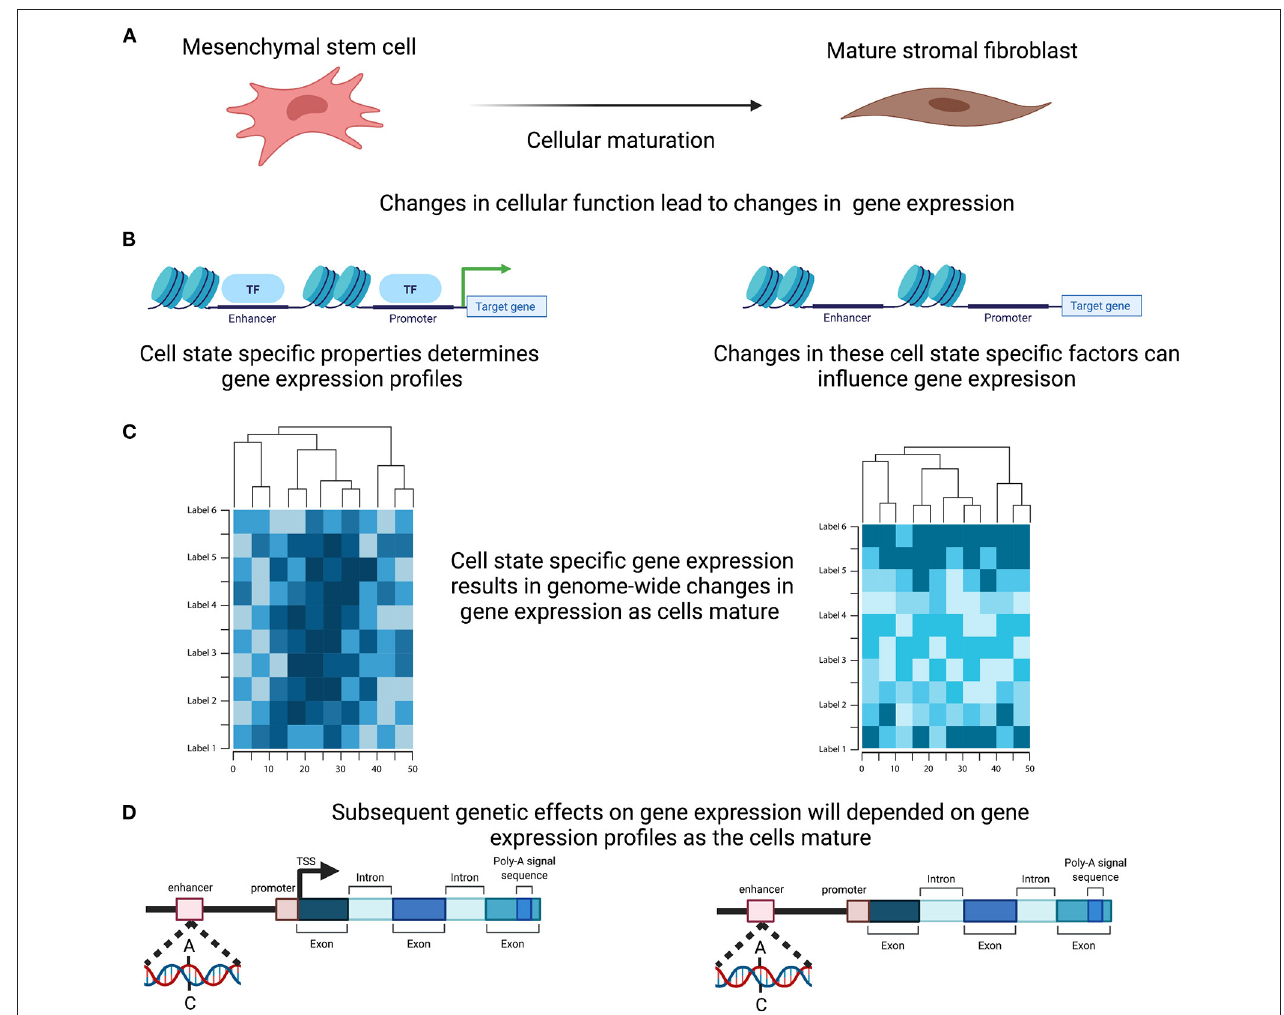
FIGURE 3 | Cell Specific genetic effects on gene expression. (A) Cells within the endometrium, such as the mesenchymal stem cells, undergo proliferation and maturation each menstrual cycle to generate a mature cell. (B) Maturation is controlled by a programmed course of gene expression that results in cell specific properties and are reflected in alteration in the active transcription. (C) In combination and across the genome these active change in expression will induce distinct genome wide gene expression profiles. (D) Genetic effects on transcription therefore will ultimately induce differing effects as the cells mature. Created with